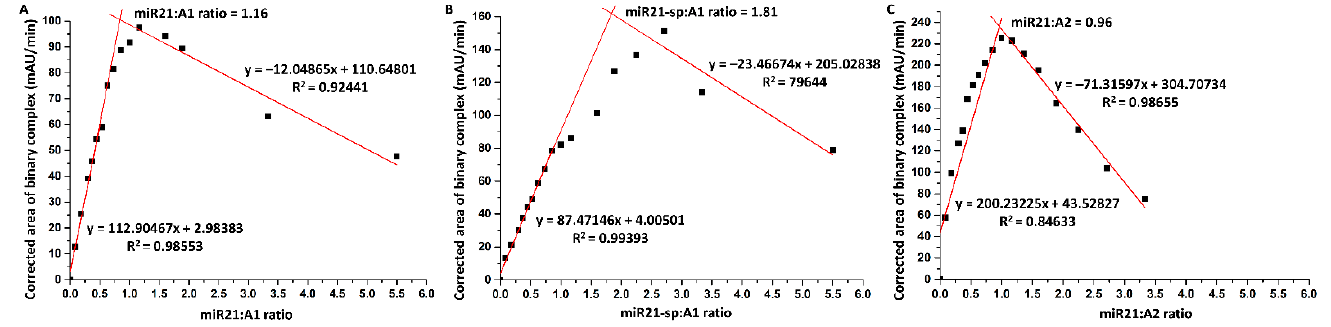
Figure 5. Job’s plot method for assessing stoichiometry for the interaction between ( A ) miR21–A1, ( B ) miR21-sp–A1, and ( C ) miR21–A2 (obs: migration time corrected peak areas were used).